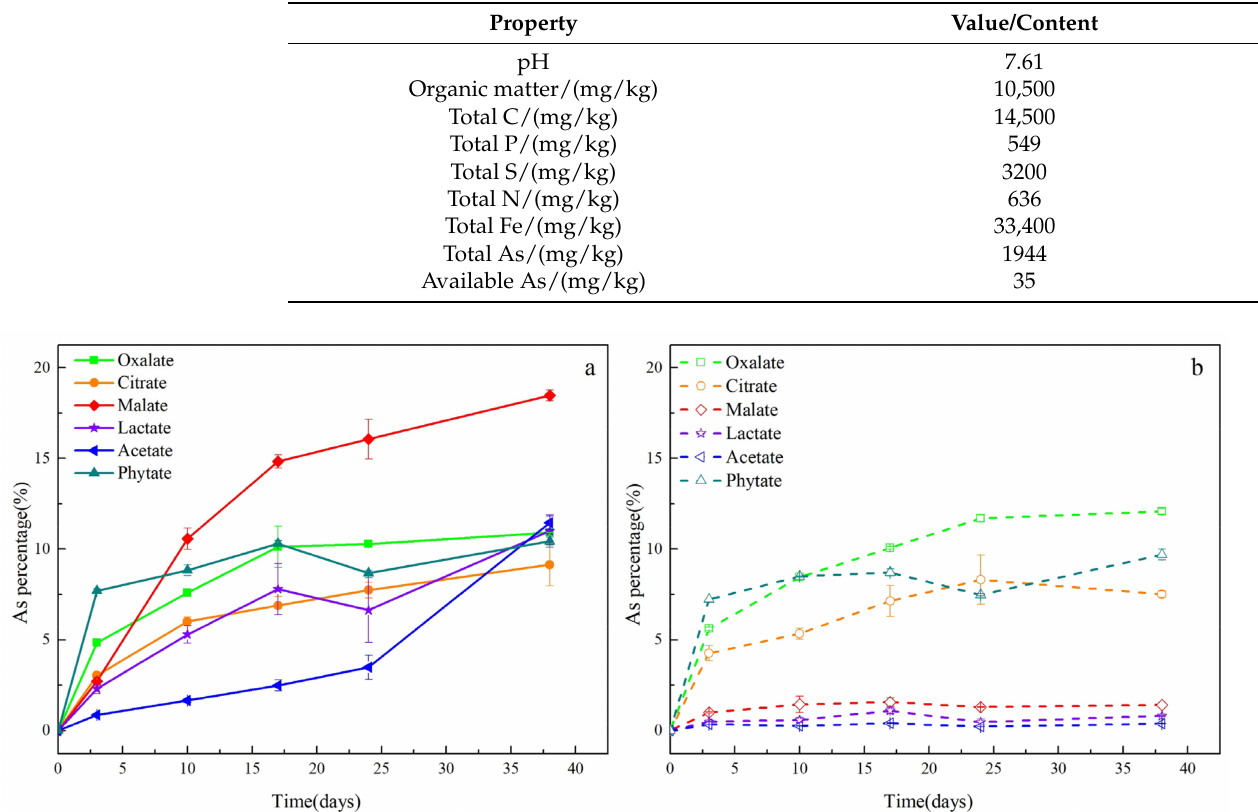
Table 1. Basic physical and chemical properties of the studied soil.